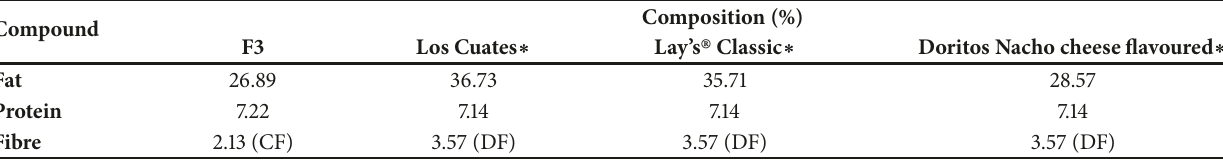
Table 6: Nutritional comparison of fried snacks with other